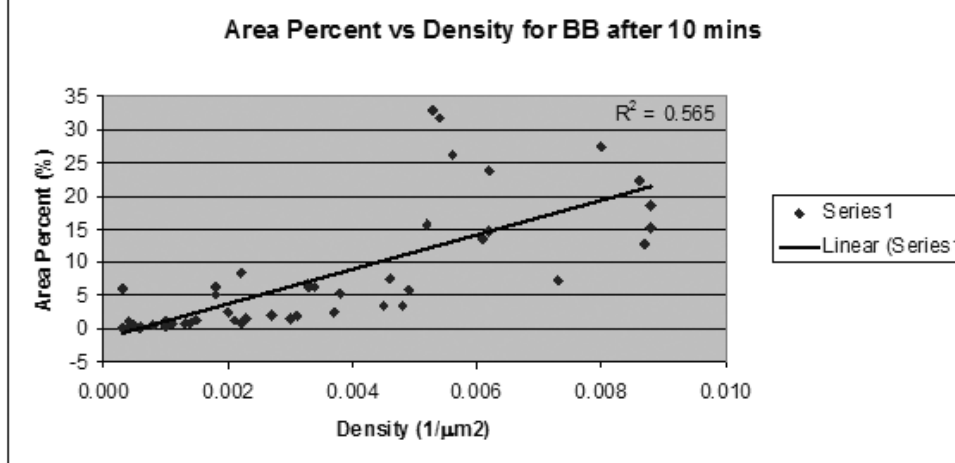
Figure 9: Area Percent vs. Density of wear for BB after 10 minutes.